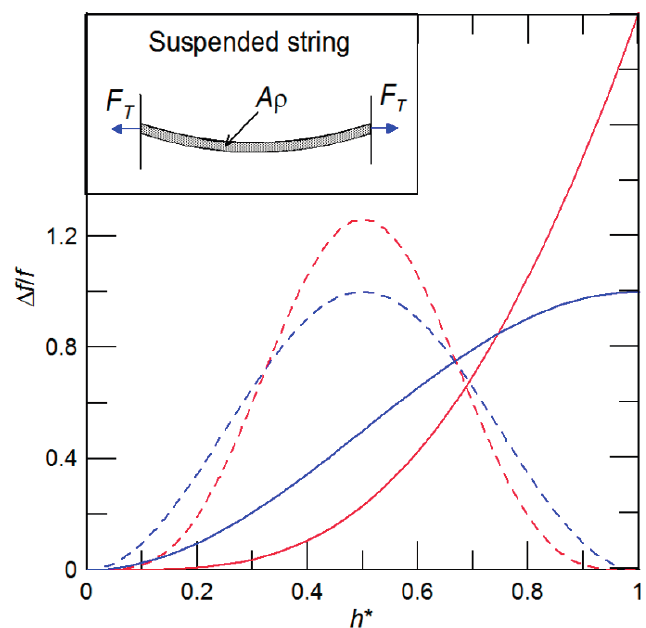
Figure 3. Dependency of the frequency shift of the fundamental mode on the dimensionless position h * for a given mass ratio and two limiting cases: beam (red line) and string (blue line) in suspended (dash line) and cantilever (solid line) configurations, respectively. Figure inset shows the sketch of pure string in a suspended